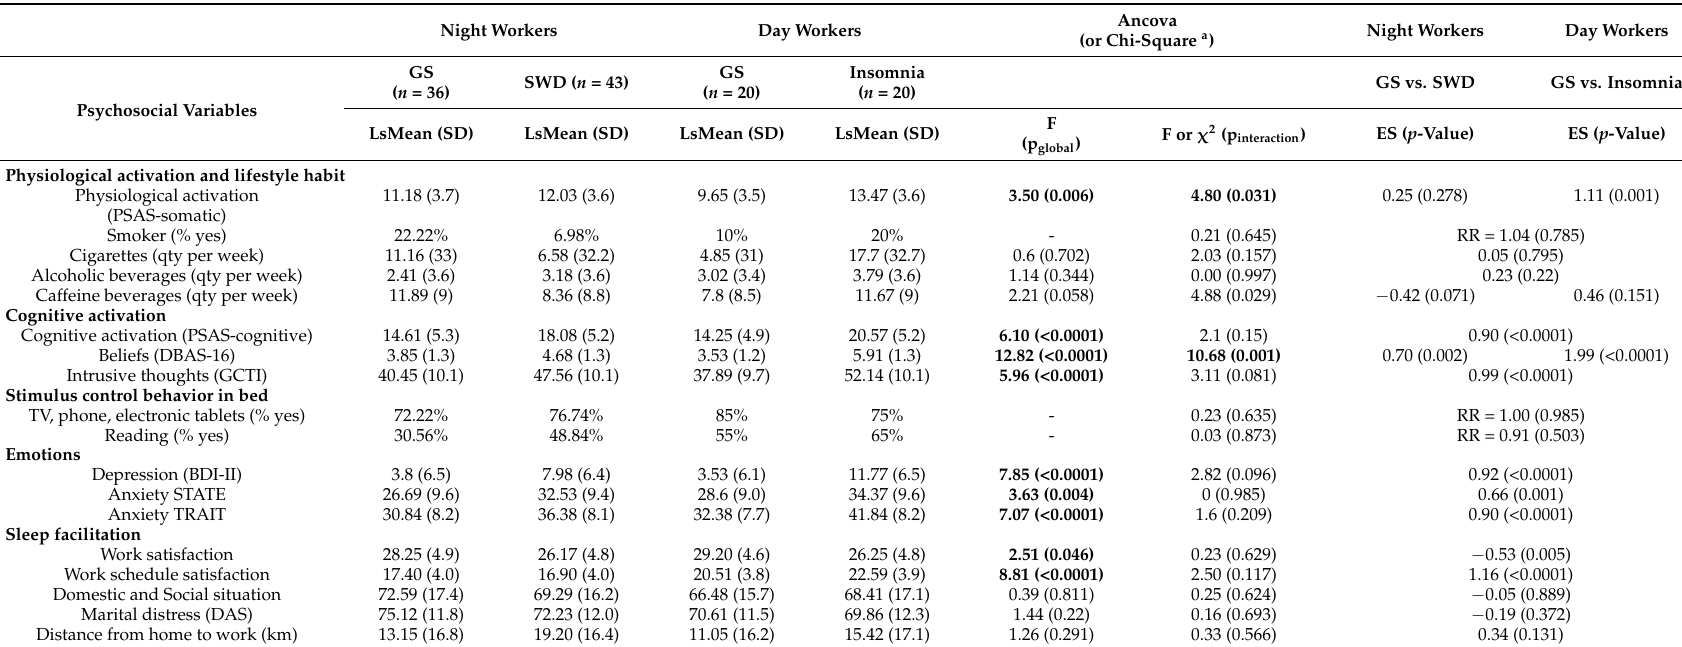
Table 5. LsMean and standard deviations for psychosocial variables according to work schedule (night or day workers) and sleep disorder (good sleep or SWD/insomnia). Night Workers Day Workers Night Workers Day